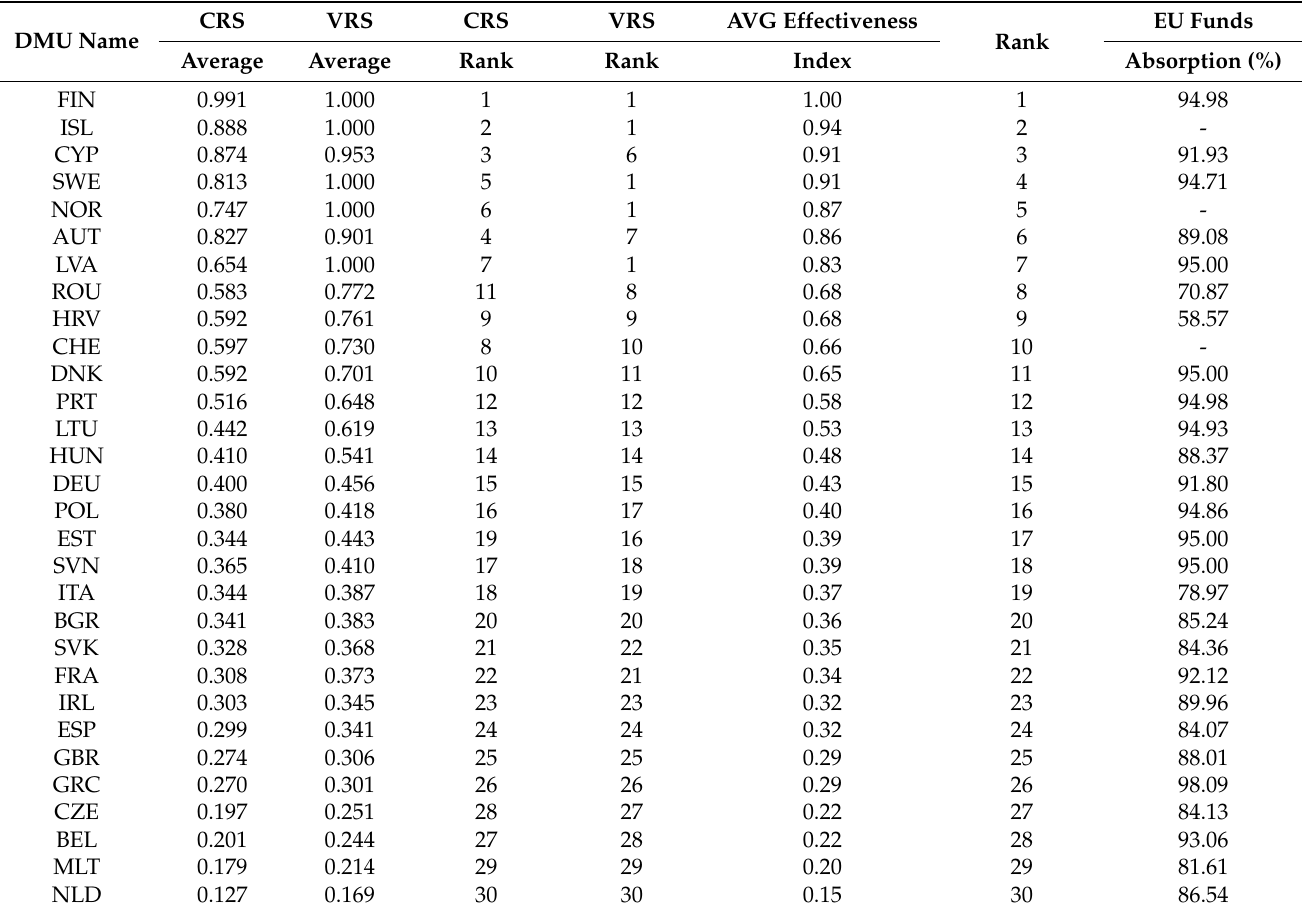
Table 7. Efficiency Ranking for European Countries. Source: Authors’ calculations in DEAFrontier; European Commission